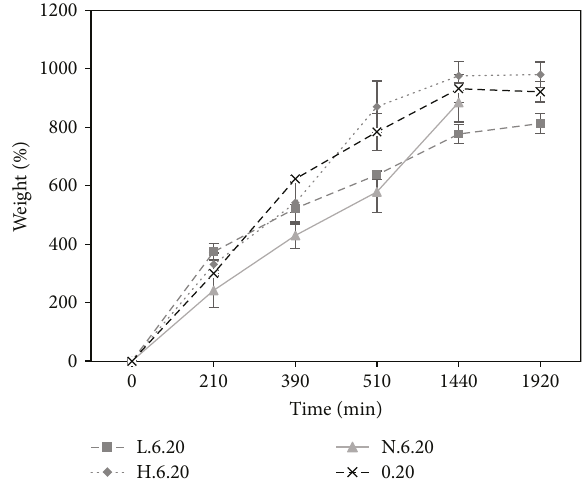
Figure 6: Swelling kinetics of xerogels. The samples used for this study were H.6.20 (6% HOP and 20% of gelatin), L.6.20 (6% LOP and 20% of gelatin), N.6.20 (6% NOP and 20% of gelatin), and 0.20 solely gelatin (20% gelatin). The weight of N.6.20 at 72h was not obtained due to the fragmentation of the